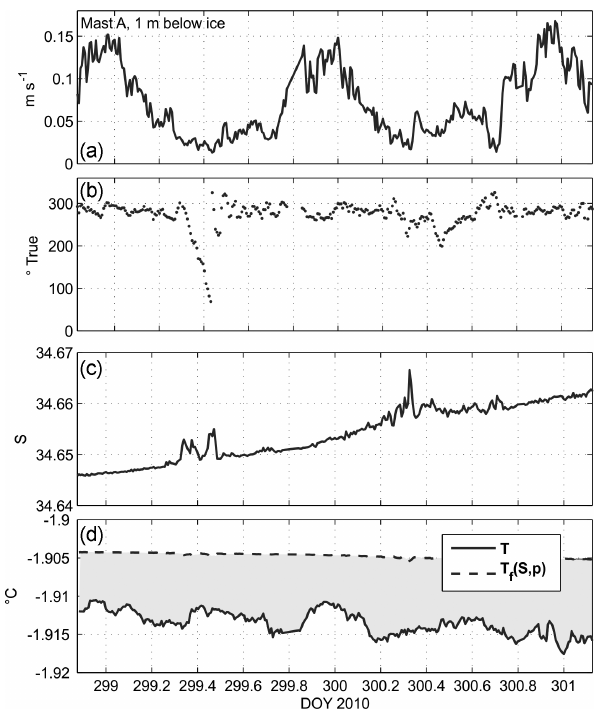
Figure 4. (a) Current speed at 1m below the ice–ocean bound- ary from Mast A. (b) Current direction (bearing from true north). (c) Salinity S (practical salinity scale). (d) Water temperature (solid) and water freezing temperature at 2m depth